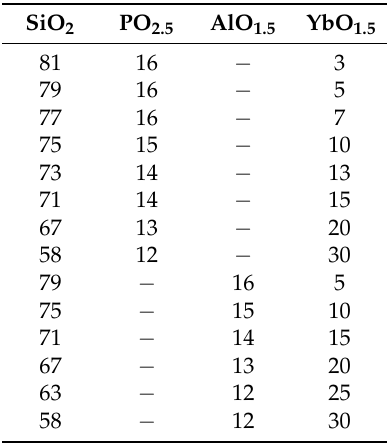
Table 3. Rare-earth doped phosphosilicate and aluminosilicate glass compositions (mol%). SiO 2